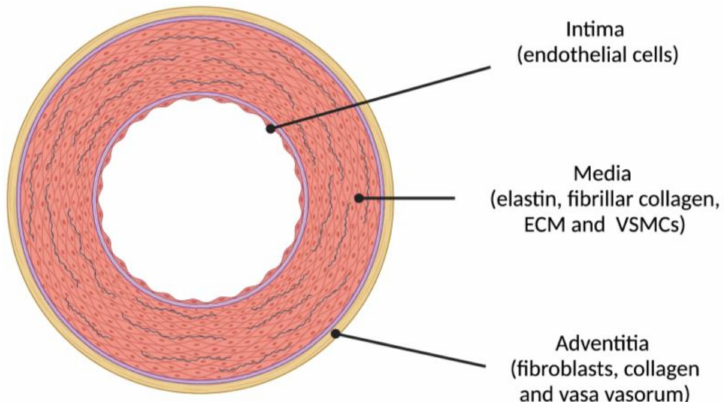
Figure 3. The three layers of the elastic arterial wall are: (1) intima (endothelial cells); (2) media (concentric layers of elastin, fibrillar collagen and other proteins integrating the extracellular matrix (ECM) and vascular smooth muscle cells (VSMCs)); and (3) adventitia (fibroblasts, collagen and, in larger arteries, vasa vasorum). Atherosclerosis initiates in the intima whereas arteriosclerosis (AS) mostly affects the